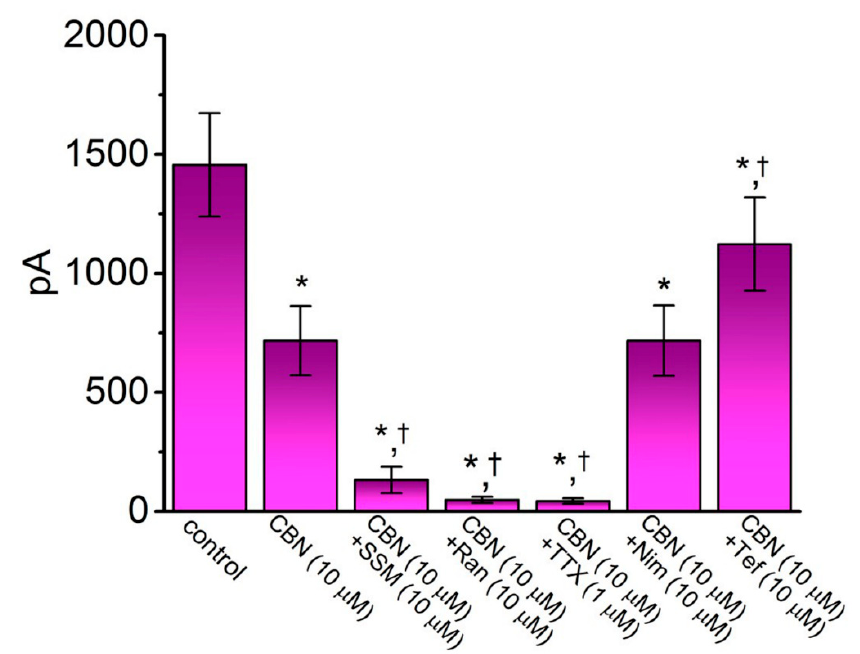
Figure 2. Comparison among effects of CBN, CBN plus sesamin (SSM), CBN plus ranolazine (Ran), CBN plus tetrodotoxin (TTX), CBN plus nimodipine (Nim), and CBN plus tefluthrin (Tef) on the amplitude of peak I Na observed in GH 3 cells. Cells were bathed in Ca 2+ -free, Tyrode’s solution, and the recording pipet was filled up with Cs + -containing solution. The I Na was activated by 50-ms depolarizing voltage command from − 80 to − 10 mV, and current amplitude at the beginning of the voltage pulse was measured. Each bar represents the mean ± SEM ( n = 7–8). * indicates significantly different from control (i.e., none of the agents were present) ( p < 0.05), and † indicates significantly different from CBN (10 µM) alone group ( p < 0.05).